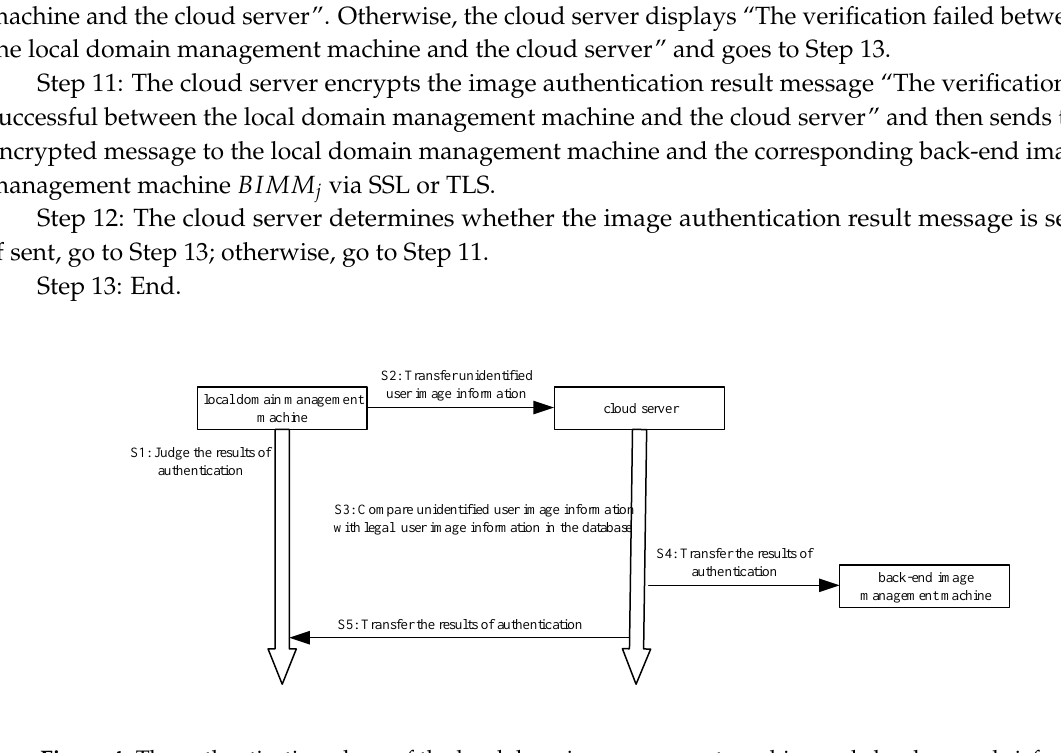
Figure 4. The authentication phase of the local domain management machine and cloud server brief process